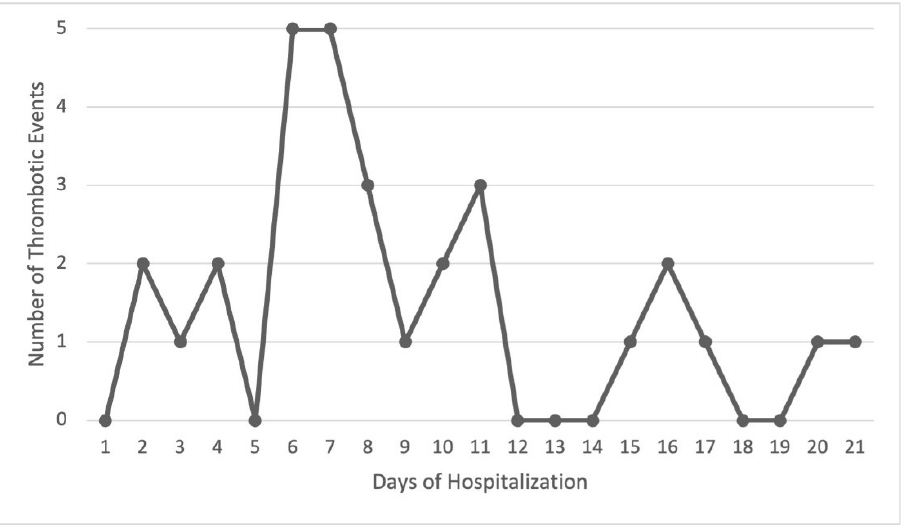
Figure 5. Day of in-hospital thrombotic event onset during hospital stay ( n = 30).